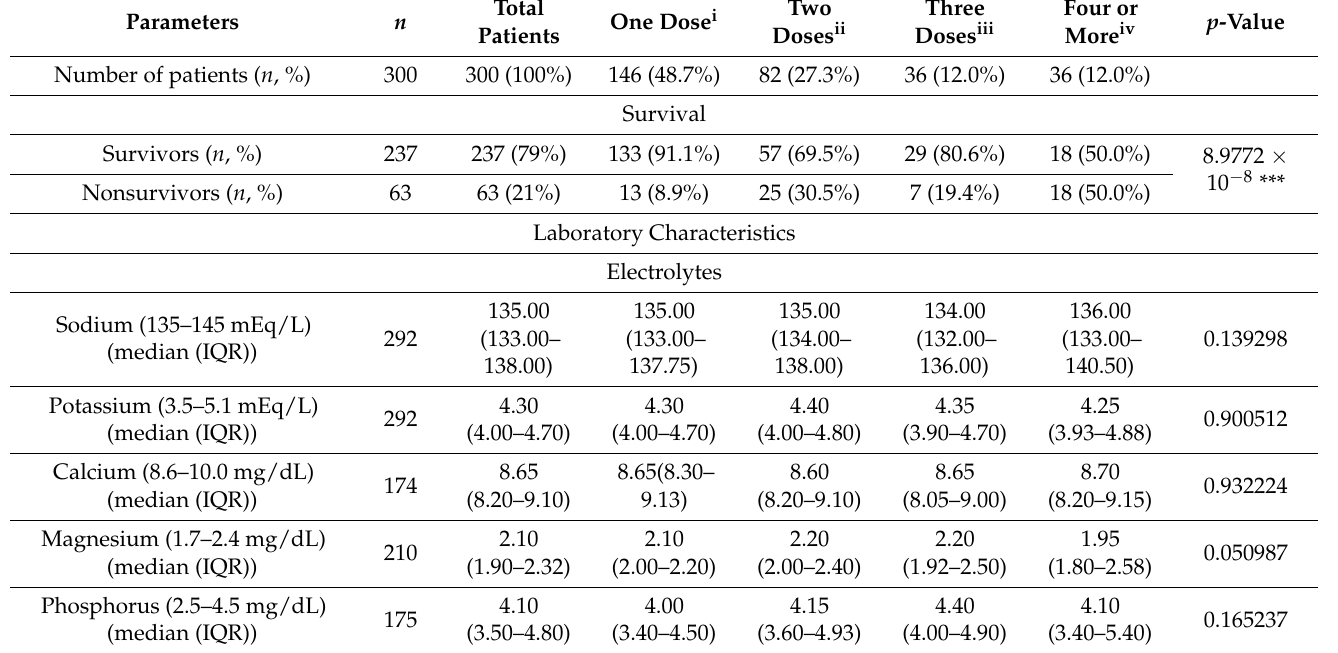
Table 4. Short-term effects of different doses of tocilizumab on the laboratory results of COVID-19 (all patients, n =